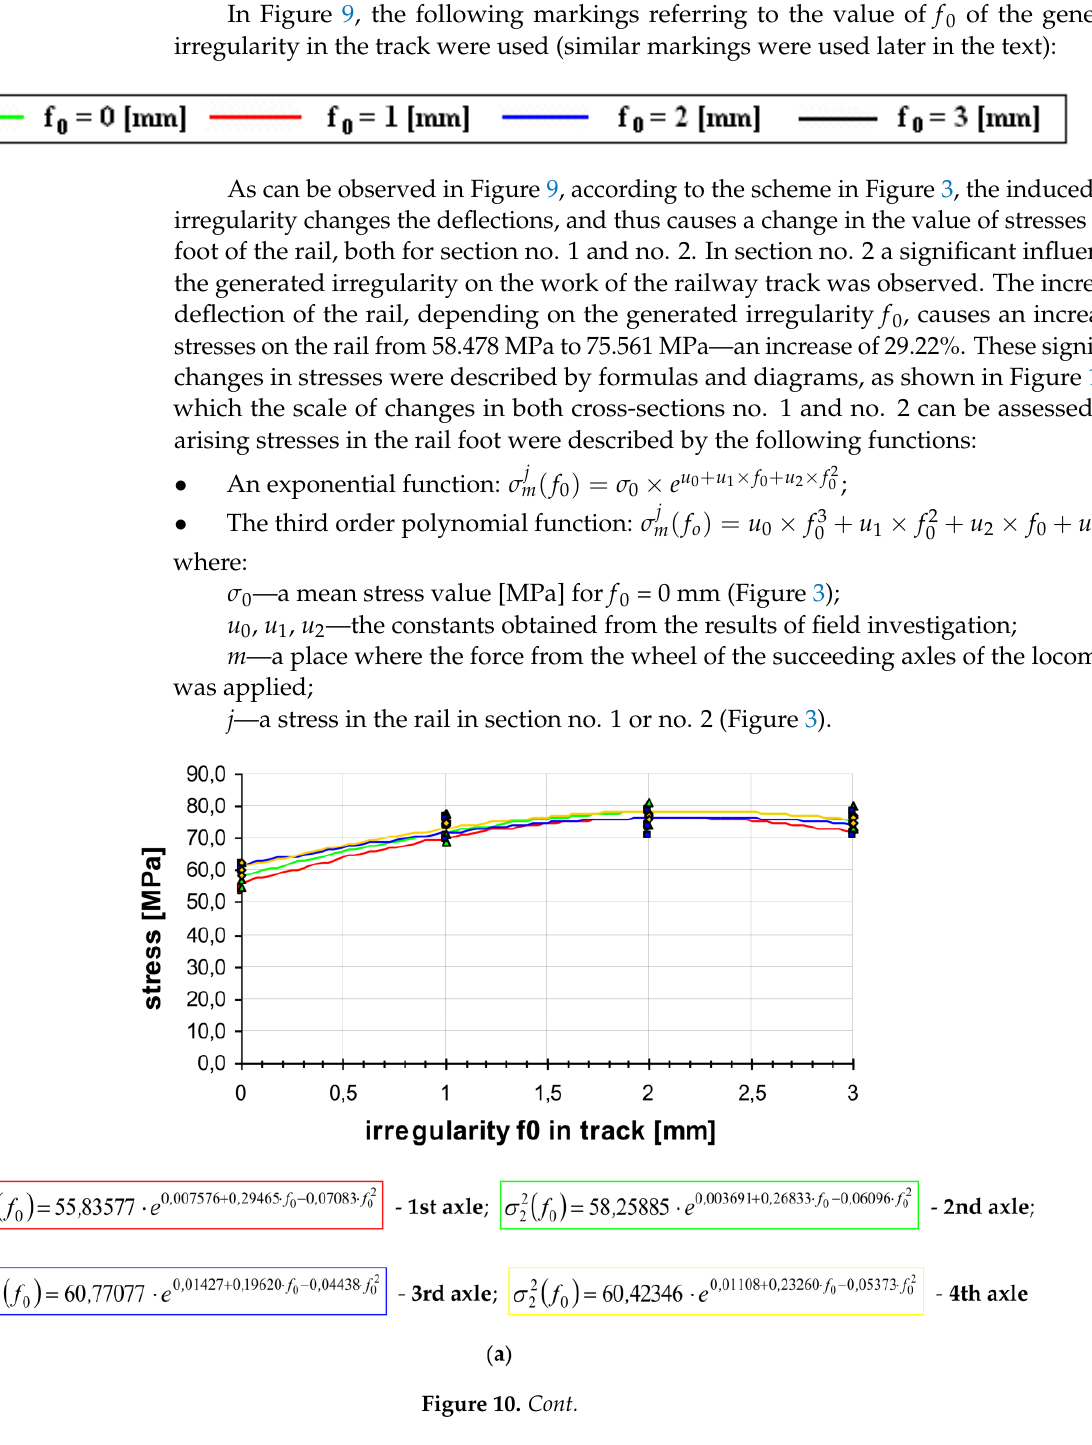
Figure 9. The rail stresses caused by induced irregularity in the railway track (the rides of locomotive’s succeeding axles): ( a ) measured by an extensometer in cross-section no. 2 (Figure 3); ( b ) measured by an extensometer in cross-section no. 1 (Figure 3).